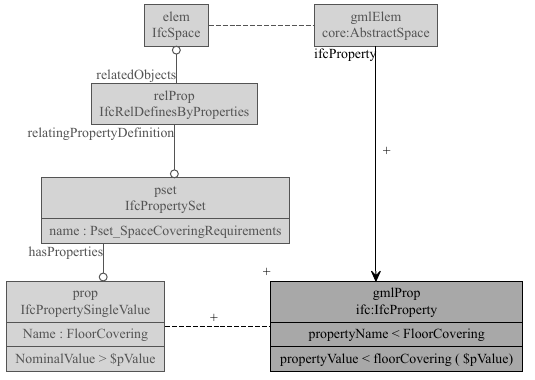
Figure 8. A rule converting a property to a new node, here the FloorCovering property of IfcSpace in IFC to an IfcProperty node.